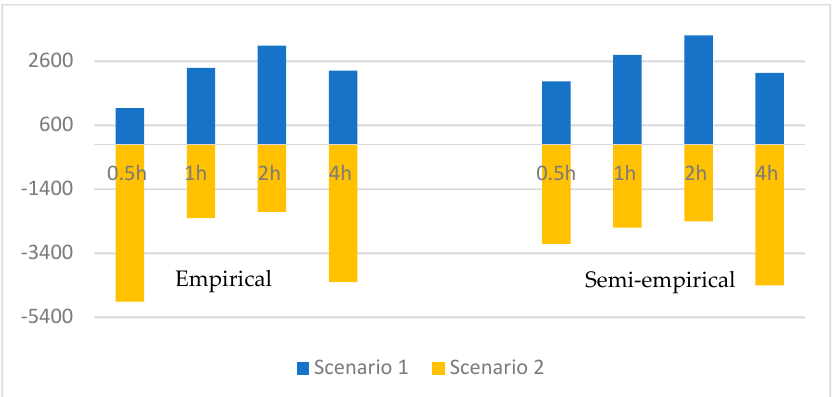
Figure 12. The total profit for the batteries in 1 year capacity market contract for both empirical and semi-empirical models assuming ideal temperatures.